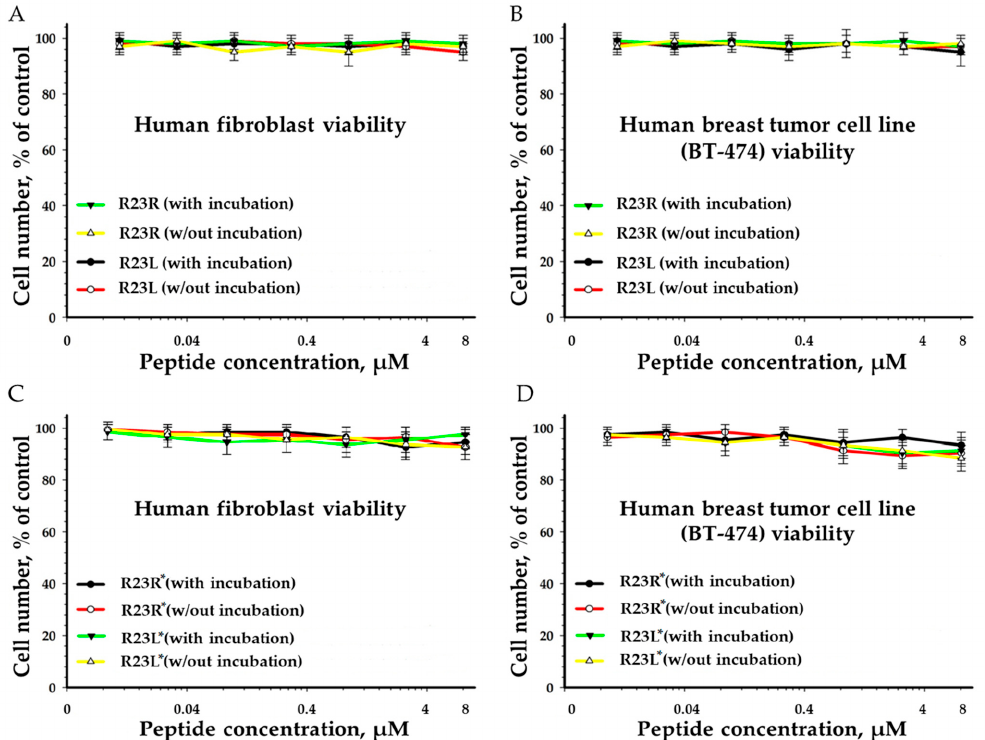
Figure 5. Effects of peptide treatment on survival the human fibroblasts ( A , C ) and breast tumor cell line BT-474 ( B , D ). Error bars show standard errors. To analyze the cytotoxic effect of peptides, cells after incubation with maximum pep- tide concentrations (8 µM) were stained with calcein-AM (stains living cells) and propid- ium iodide (stains dead cells). It was shown that all BT474 cells as well as fibroblasts re- mained alive after 24 h of incubation with the R23R and R23L peptides. The results of this work show that the studied peptides do not alter the viability of both BT474 human breast duct carcinoma cells and human fibroblasts at maximum concentrations (8 µM). The ab- sence of the cytotoxic effect of the studied peptides was shown. 2.4. Amyloidogenic Properties of Synthesized Peptides It is known that thioflavin T (ThT) has the ability to bind to amyloids and amyloid- like fibrils. This process is recorded by a multiple increase in the ThT fluorescence inten- sity at a wavelength of ~485 nm. ThT fluorescence spectra were obtained after 24 h of incubation at 37 °C of the dye with different concentrations of the R23R, R23L, R23R*, and R23L* peptides (Figure 6).